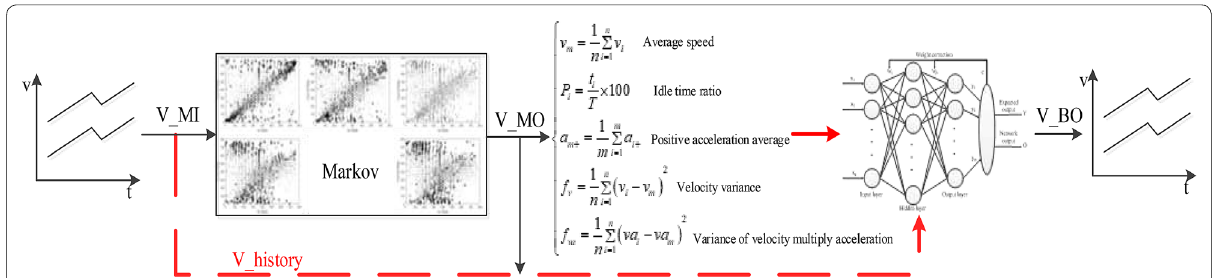
Figure 9 MBNN2 combined prediction